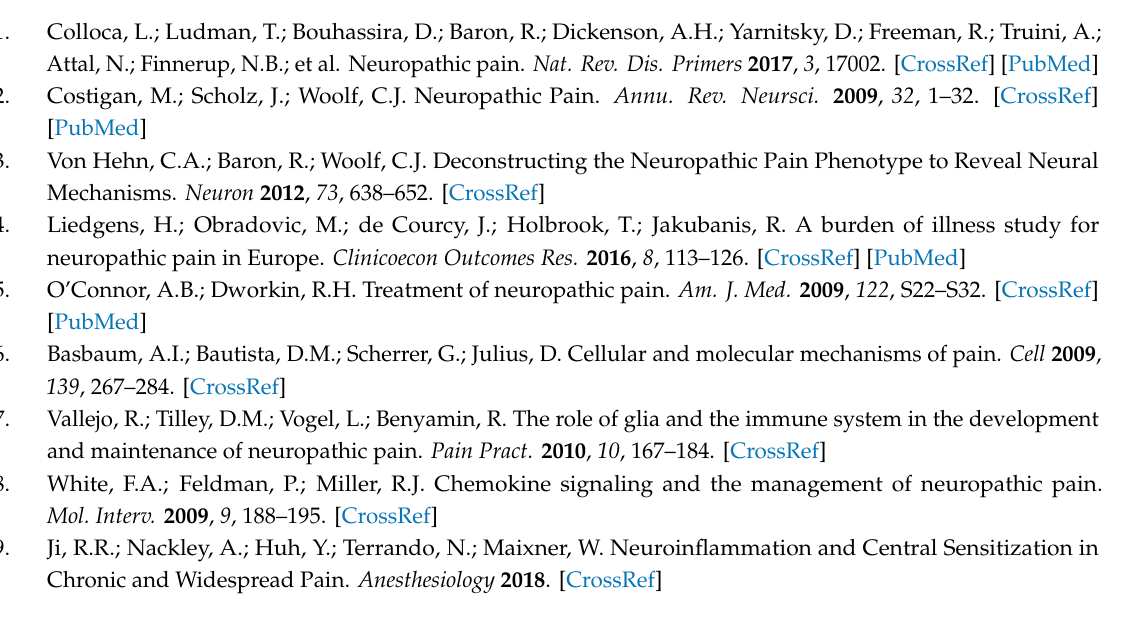
Figure S1: Activated astrocytes in spinal cord 7d after SNI, Figure S2: Cytokine and chemokine production in nervous tissue after SNI surgery, Figure S3: Stress reactions in G2A-deficient mice and in BMDMs after stimulation with 9-HODE, Figure S4: Immune cell number, cytokine and chemokine production in nervous tissue 7d after SNI surgery, Figure S5: E ff ect of 9-HODE on migratory signaling pathways, Table S1: Overview of regulated proteins in wild-type BMDMs treated with 1 µ M 9-HODE for 24 h, Table S2: Overview of regulated proteins in untreated G2A-deficient and wild-type